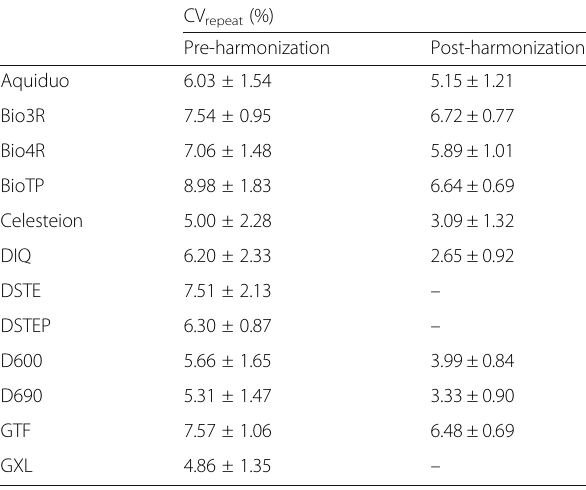
Table 3 Pre- and post-harmonization coefficients of variation across 15 frames of 12 PET